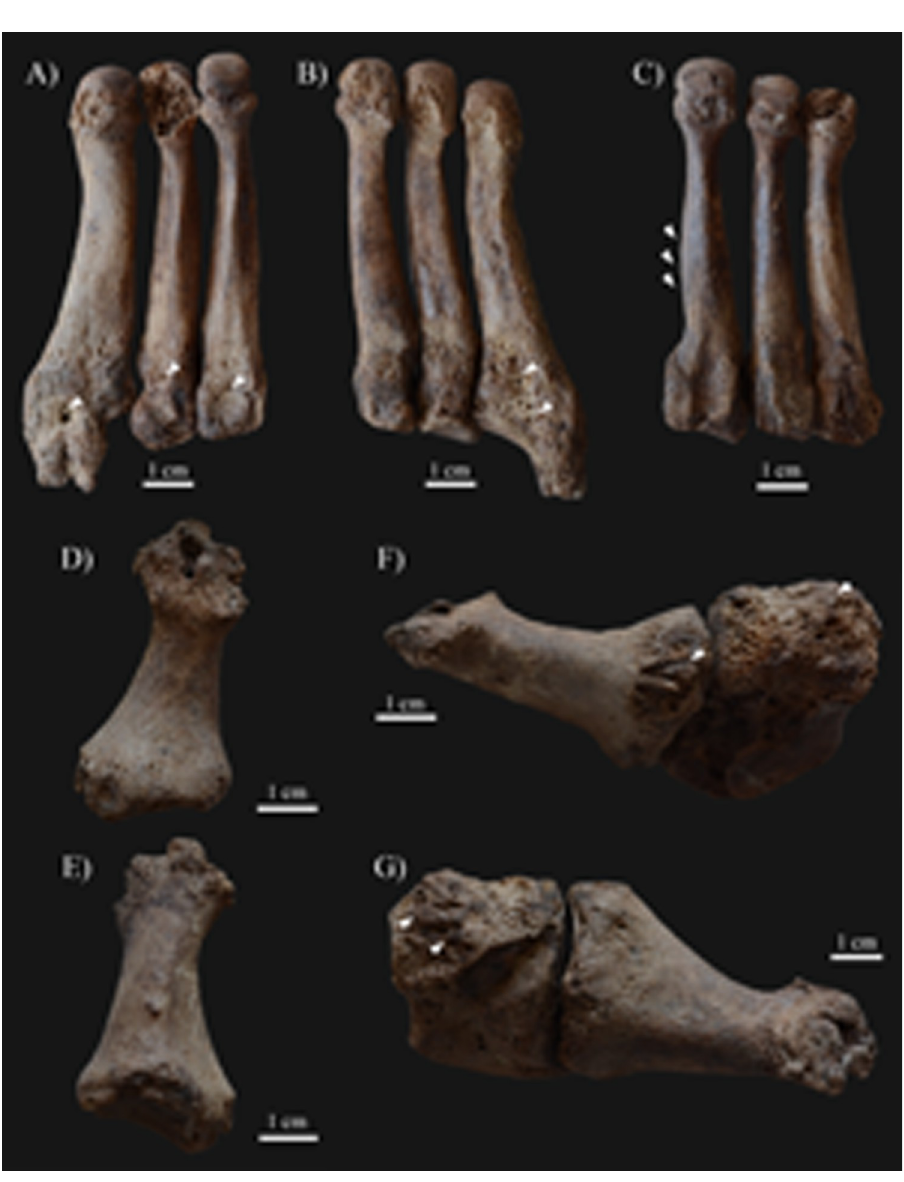
Fig 7. Septic bony changes indicative of sensory peripheral neuropathy in the feet of KK61. Surface pitting and subperiosteal new bone formations on the A) dorsal and B) plantar surfaces of the proximal end of the left 3 rd , 4 th , and 5 th metatarsals (white arrows), with a small sinus on the 5 th metatarsal; C) Slight ballooning of the diaphysis of the right 2 nd metatarsal (white arrows); Almost complete destruction of the distal end of the right 1 st metatarsal–D) plantar and E) dorsal surfaces; and Remodelling of the proximal end of the right 1 st metatarsal and the right medial cuneiform bone with surface pitting and subperiosteal new bone formations (white arrows)–F) right lateral and G) left lateral